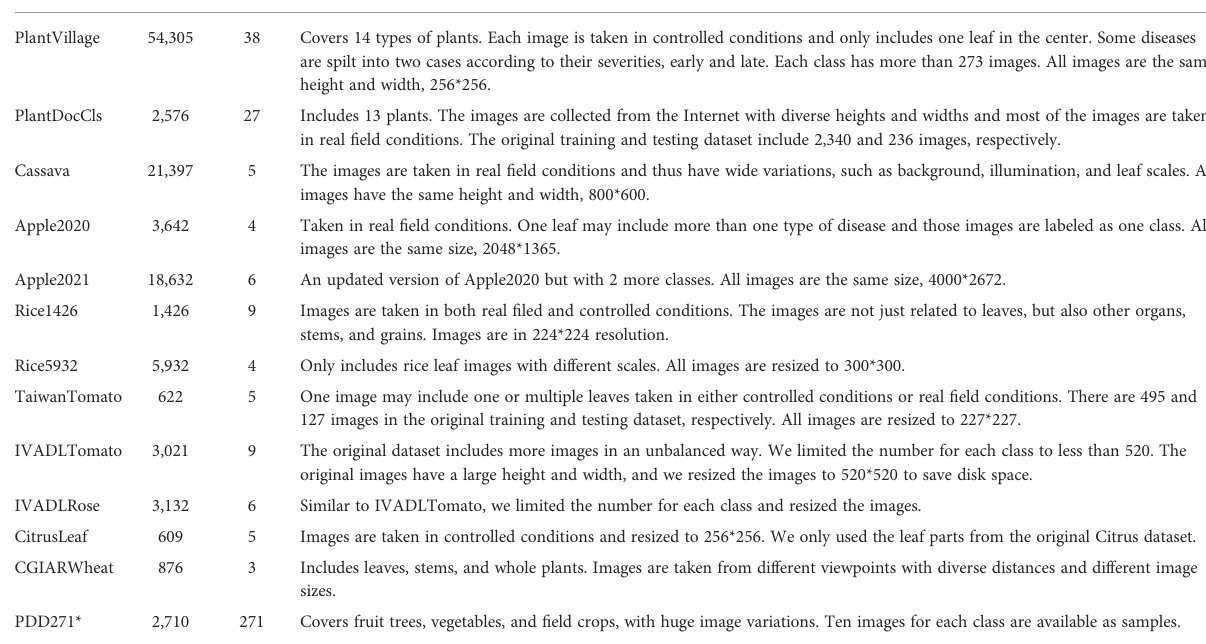
TABLE 1 Information of the used plant disease recognition datasets. Dataset Images